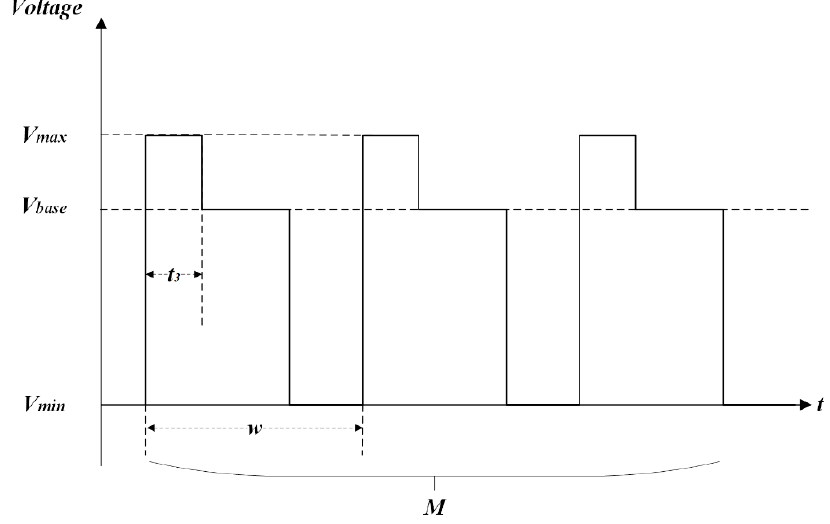
Figure 11. Driving waveform diagram in the start-up driving phase.